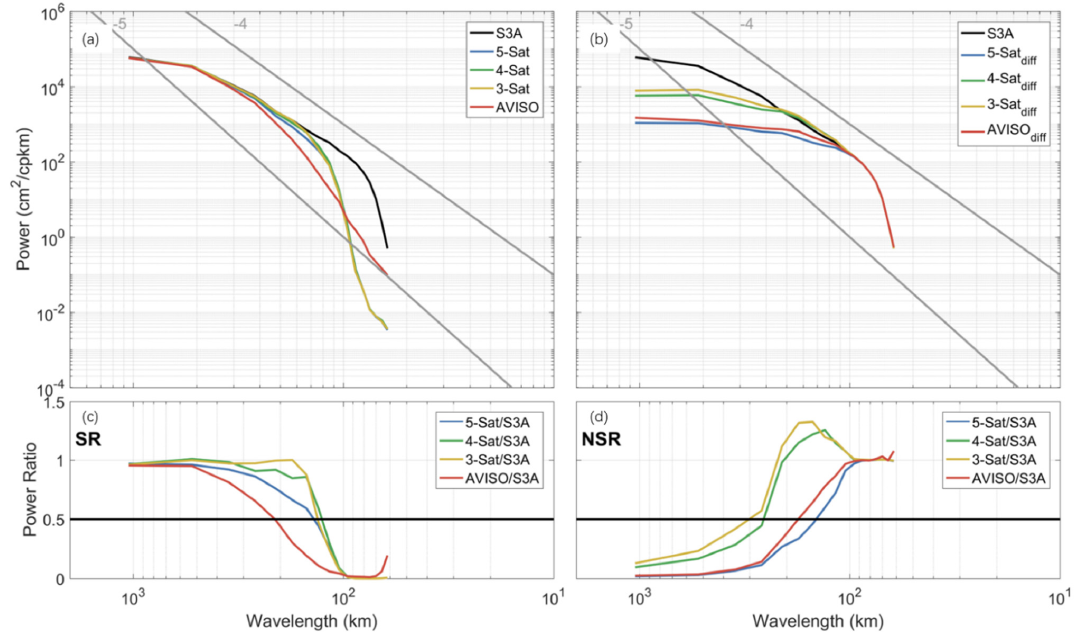
Figure 4. ( a ) Averaged PSD from along-track filtered S3A (black), 2-DVar (blue), 4-Sat (green), 3-Sat (yellow) and AVISO (red). ( b ) Averaged PSD from along-track filtered S3A (black), averaged PSD from the difference between S3A and 2-DVar (blue), 4-Sat (green), 3-Sat (yellow) and AVISO (red). ( c ) Averaged PSD ratio of 2-DVar (blue), 4-Sat (green), 3-Sat (yellow) and AVISO (red) to S3A. ( d ) Averaged PSD ratio of the difference between S3A and 2-DVar (blue), 4-Sat (green), 3-Sat (yellow) and AVISO (red) to S3A.